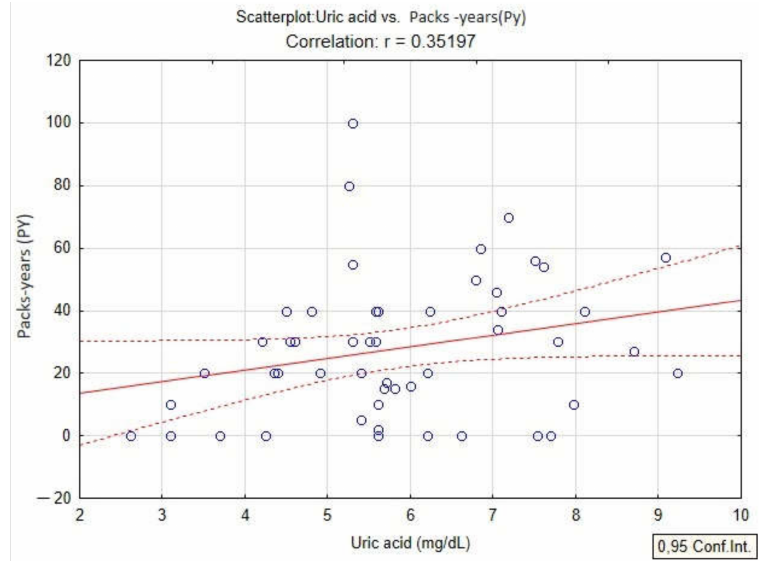
Figure 5. Linear regression between serum uric acid and packs-years (PY) in patients with